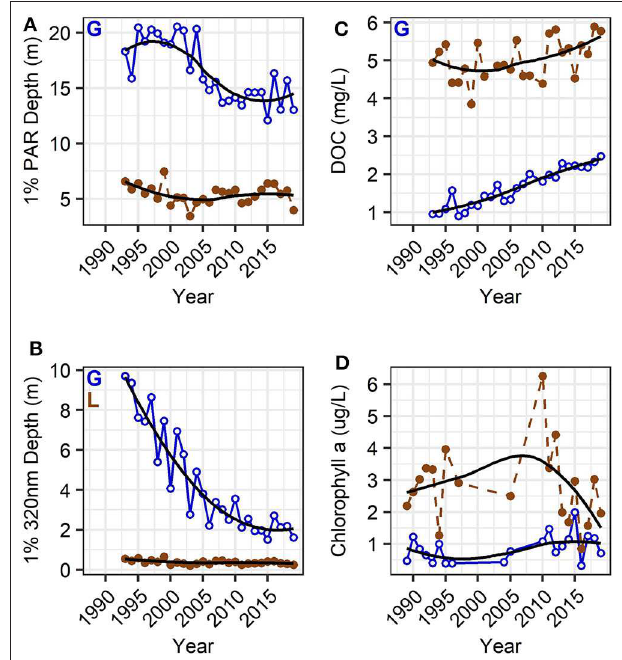
FIGURE 2 | Long-term summer average (June, July, August) trends of PAR (A) and 320nm UVR radiation (B) , DOC (C) , and chlorophyll a (D) in Lake Giles (blue, open circles with solid line), and Lake Lacawac (brown, filled circles with dashed line). There was an abrupt change in PAR in Lake Giles following a strong variation in 2003–2004 that provided contrasting underwater PAR environments in the periods before 2003 and after 2004. Trends of change in UVR were much more gradual, and not as strong in Lacawac. Letters indicate statistically significant long-term trends in Giles (“G”) and in Lacawac (“L”; Mann-Kendall non-parametric trend test, p < 0.05). Black trend lines are LOESS smoothed